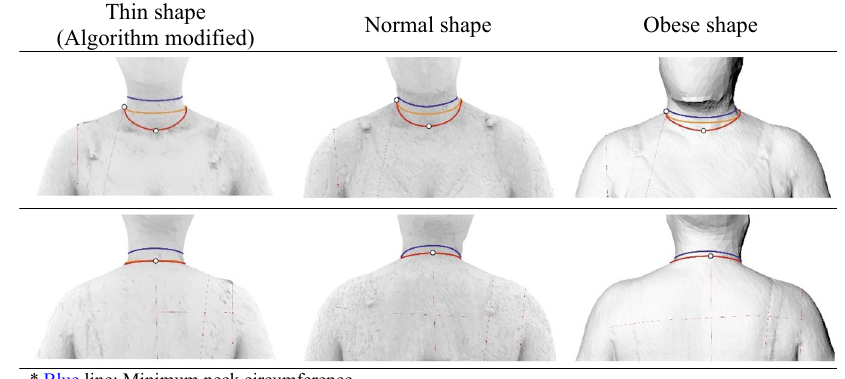
Fig. 3 The neck points identified by the algorithm by BMI-based body shape